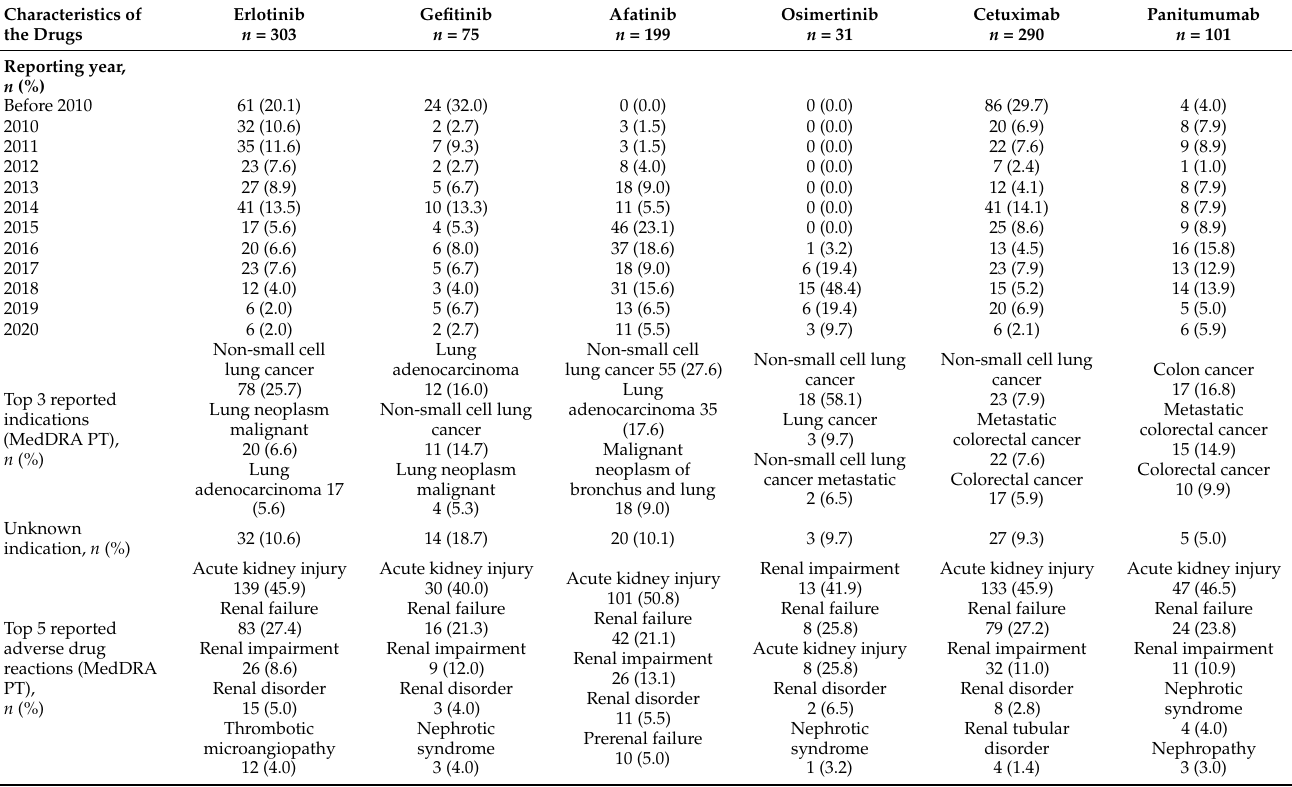
Table 2. Main indications and adverse drug effects reported for the 6 studied drugs targeting EGFR. PT: preferred term. Characteristics of the Drugs